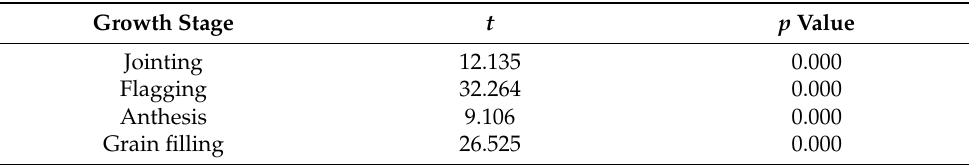
Table 4. Results from the paired sample t -test. Growth Stage